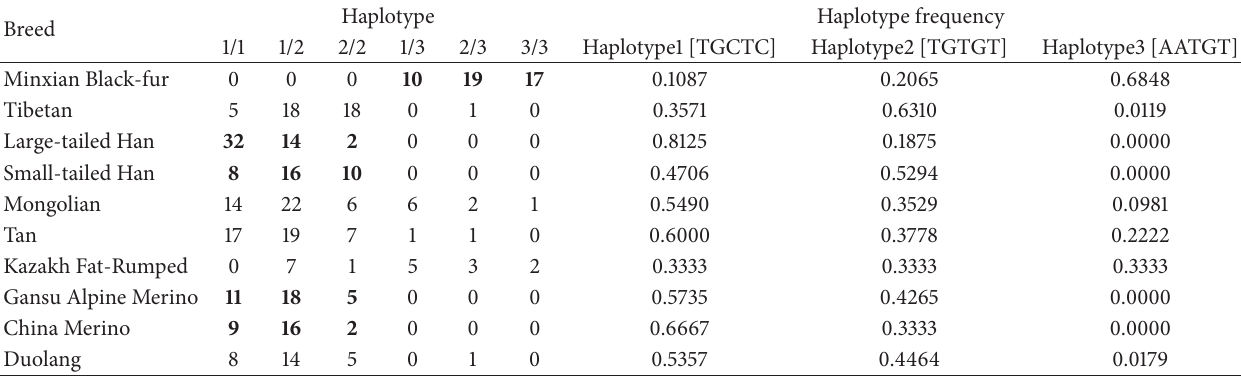
Table 3: Haplotype and haplotype frequencies at MC1R in 10 Chinese sheep